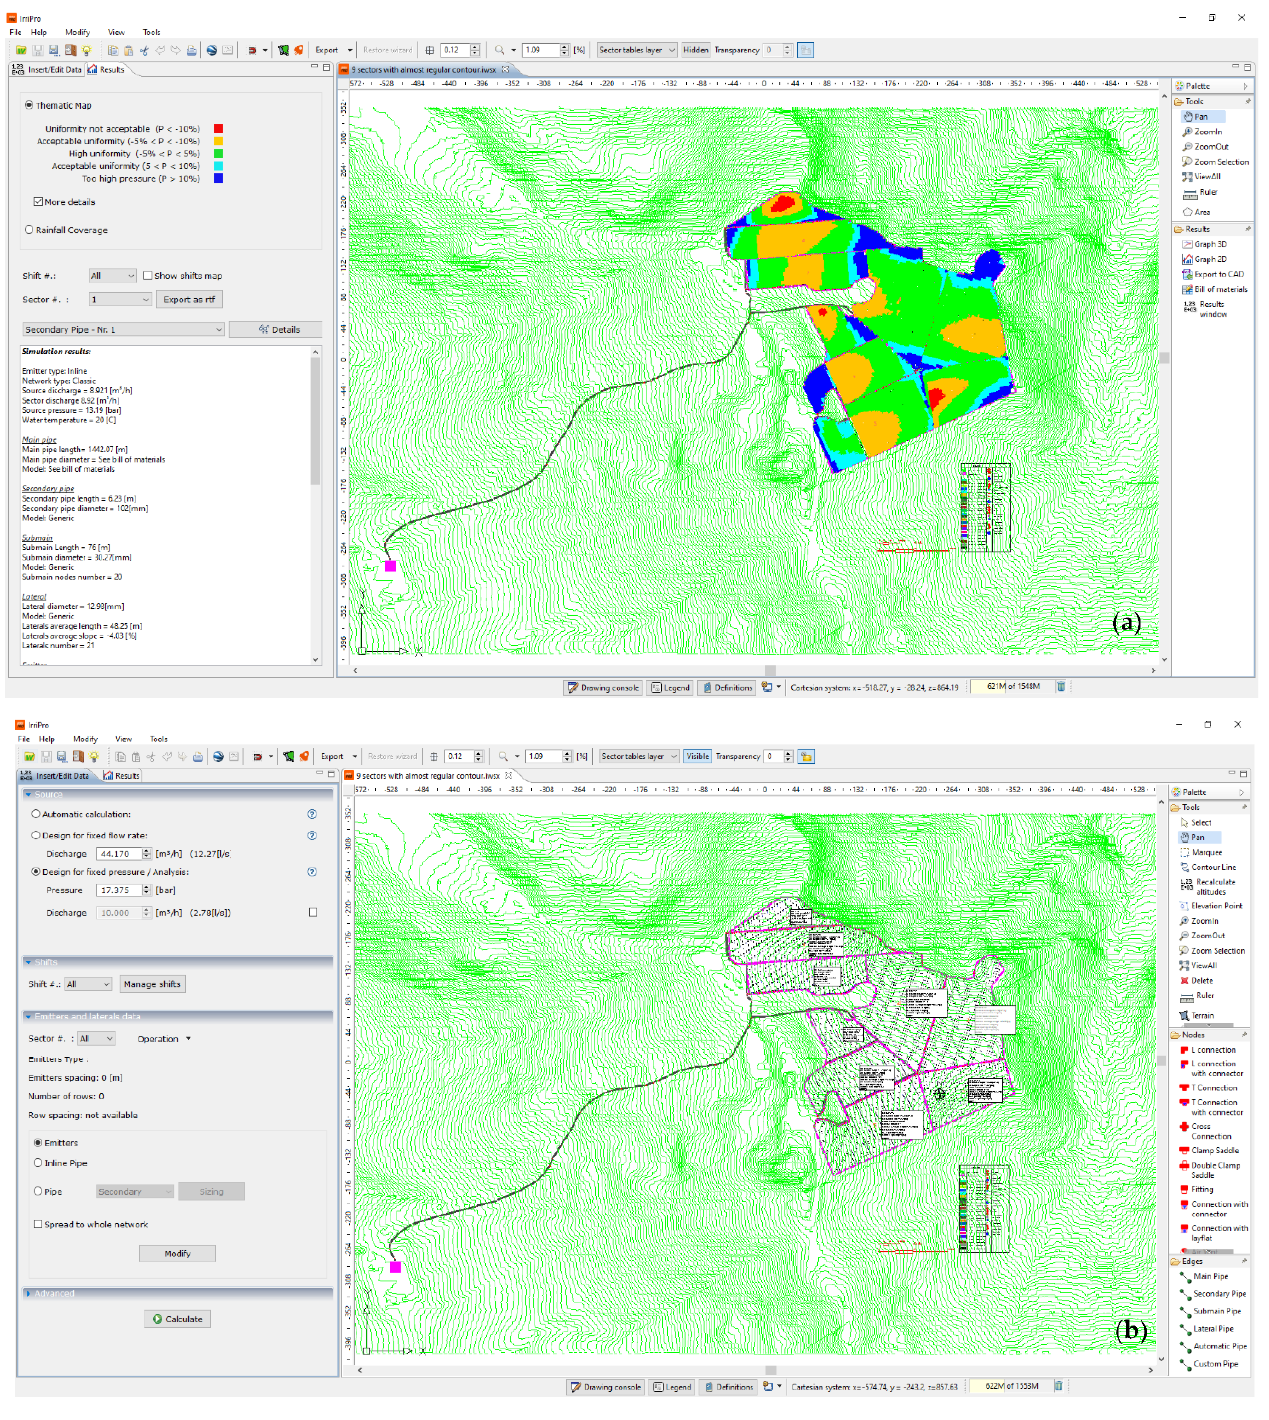
Figure 2. The two main interfaces of IRRIPRO software, ( a ) the main output data panel, and ( b ) the main input data panel.